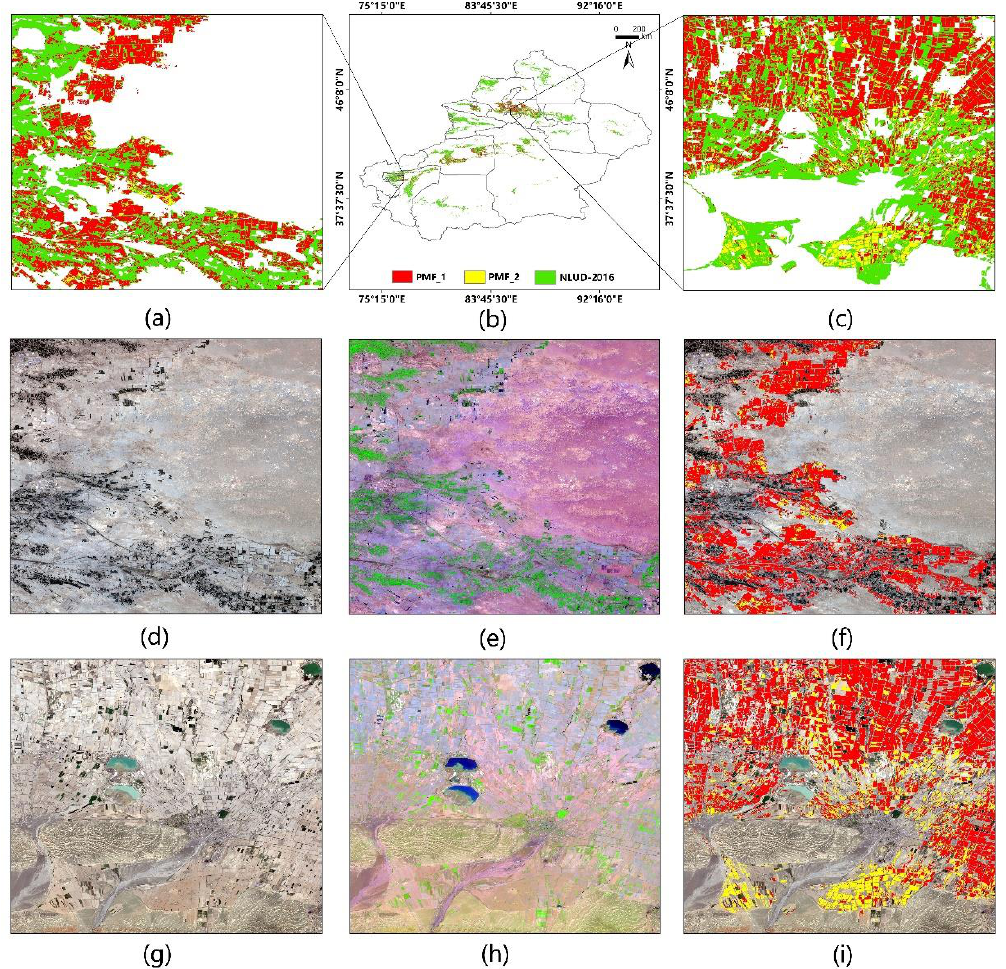
Figure 7. The spatial distribution of PMF extracted from PFMA in Xinjiang in 2016 (PMF_1: plastic-mulched farmland_1 areas; PMF_2: plastic-mulched farmland_2 areas; NLUD-2016: National Land Use Dataset in China in 2016): ( a ) The PMF extraction results in the whole Xinjiang (the red color represents PMF in the year 2016 as detected with our proposed method, and the green color represents cropland from the NLUD-2016, which shows the overall extent of agriculture in Xinjiang, China, as of the year 2016); ( b ) the PMF extraction results in the southern part of Xinjiang; ( c ) the PMF extraction results in the northern part of Xinjiang; ( d , g ) true color composite of sentinel-2 MSI; ( e , h ) arbitrary color composite of Sentinel-2 (R = SWIR 2, G = NIR, B = Blue); and ( f , i ) comparison of PMF extraction results with Sentinel-2 true color composite data.